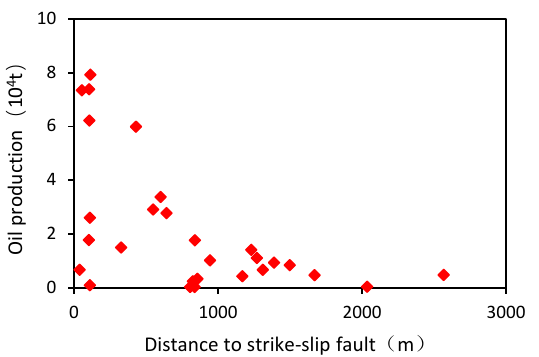
Figure 10. The oil production of the carbonate rocks vs. distance to strike-slip fault in the western area.